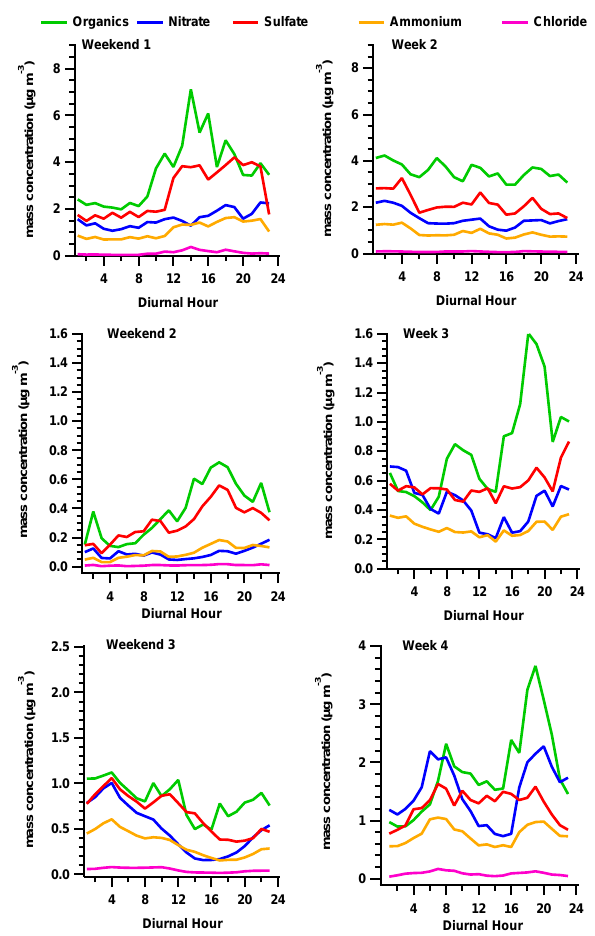
Fig. 2. Diurnal variations of the aerosol composition during week- ends (left) and weeks (right). Week and weekend number referred to time periods described in Fig.